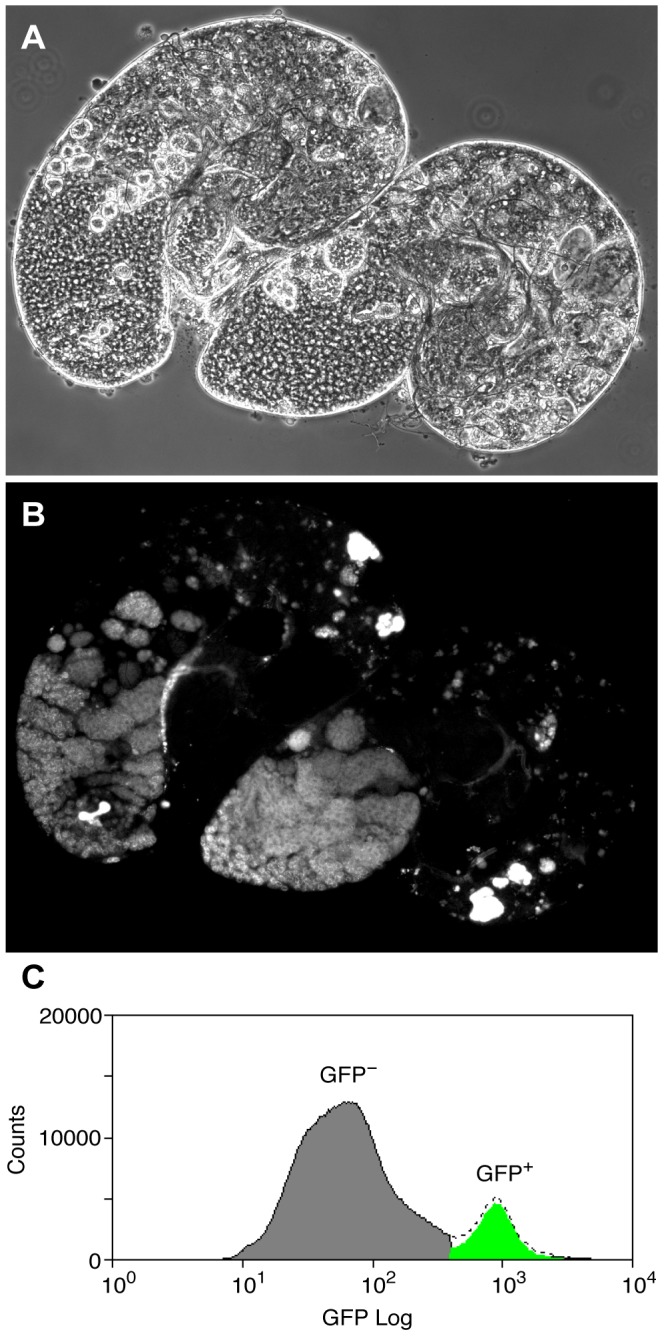
The germline precursor population.(A,B) bam mutant vas-GFP testes; the phase contrast image (A) shows the expanded precursor population and lack of primary spermatocytes and later stages; the fluorescence image (B) shows the GFP+ precursor cells. (C) FACS histogram showing the sorted precursor cells in green. The GFP-negative population (grey) represents somatic cells and debris.